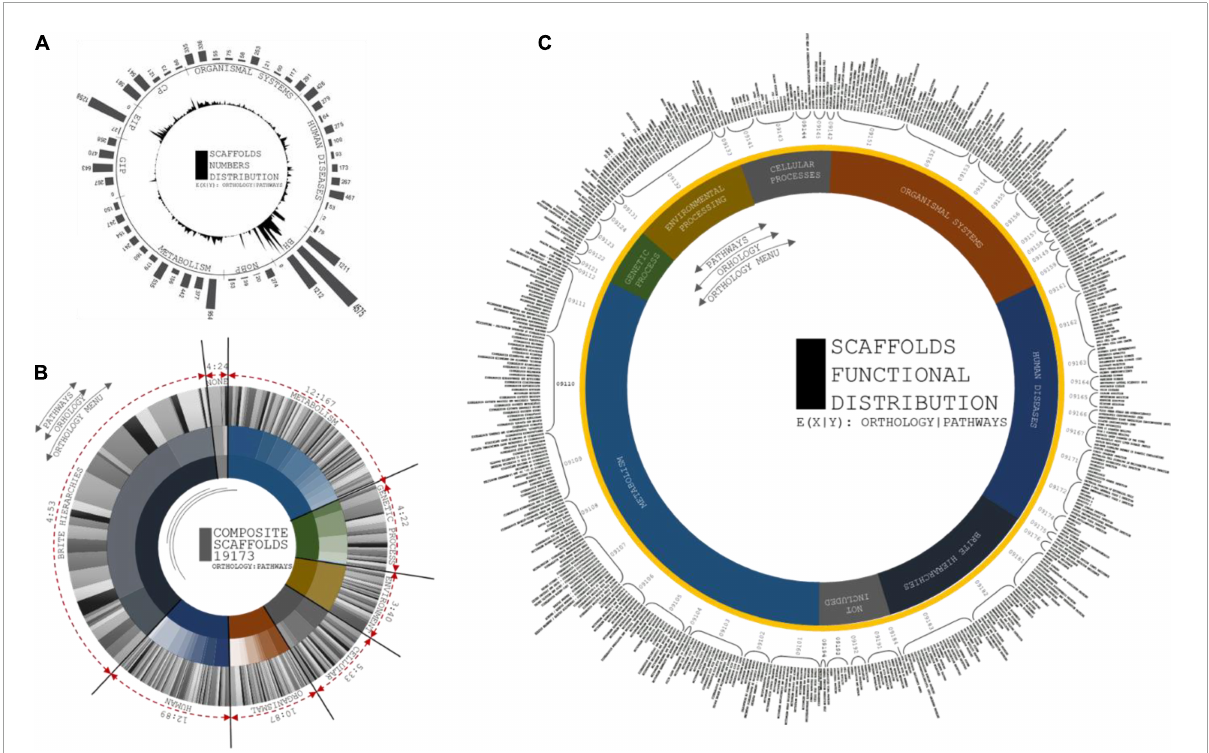
FIGURE7 (A) Circular and distribution peaks are projected from number of scaffolds involved in each orthologs. First layer of circular projections shows the maximum peaks of scaffolds distributions from each pathways categorized in orthologs. Second layer depicts the number of pathways with respect to scaffolds involvement to predict its pathway functions. (B) Circular distributions of pathways from ortholog head. Composition of three layers are coordinated by number orthologs, number of pathways from each orthologs, and scaffolds distributions at each pathways. First layer projected for number of orthologs from KAAS server, second layer depicts the number of pathways from seven ortholog head, and third layer distributed based on scaffold involved in each pathways predicted. (C) Circular projections of functional specification of Pathways predicted from KASS automated server. Plot coordinates are differentiated in three layers. First layer specifies orthology menu of the pathways from prediction profile. Second layer specifies compositional head of pathway ID and third layer is to specific functions of each pathways that corresponds from